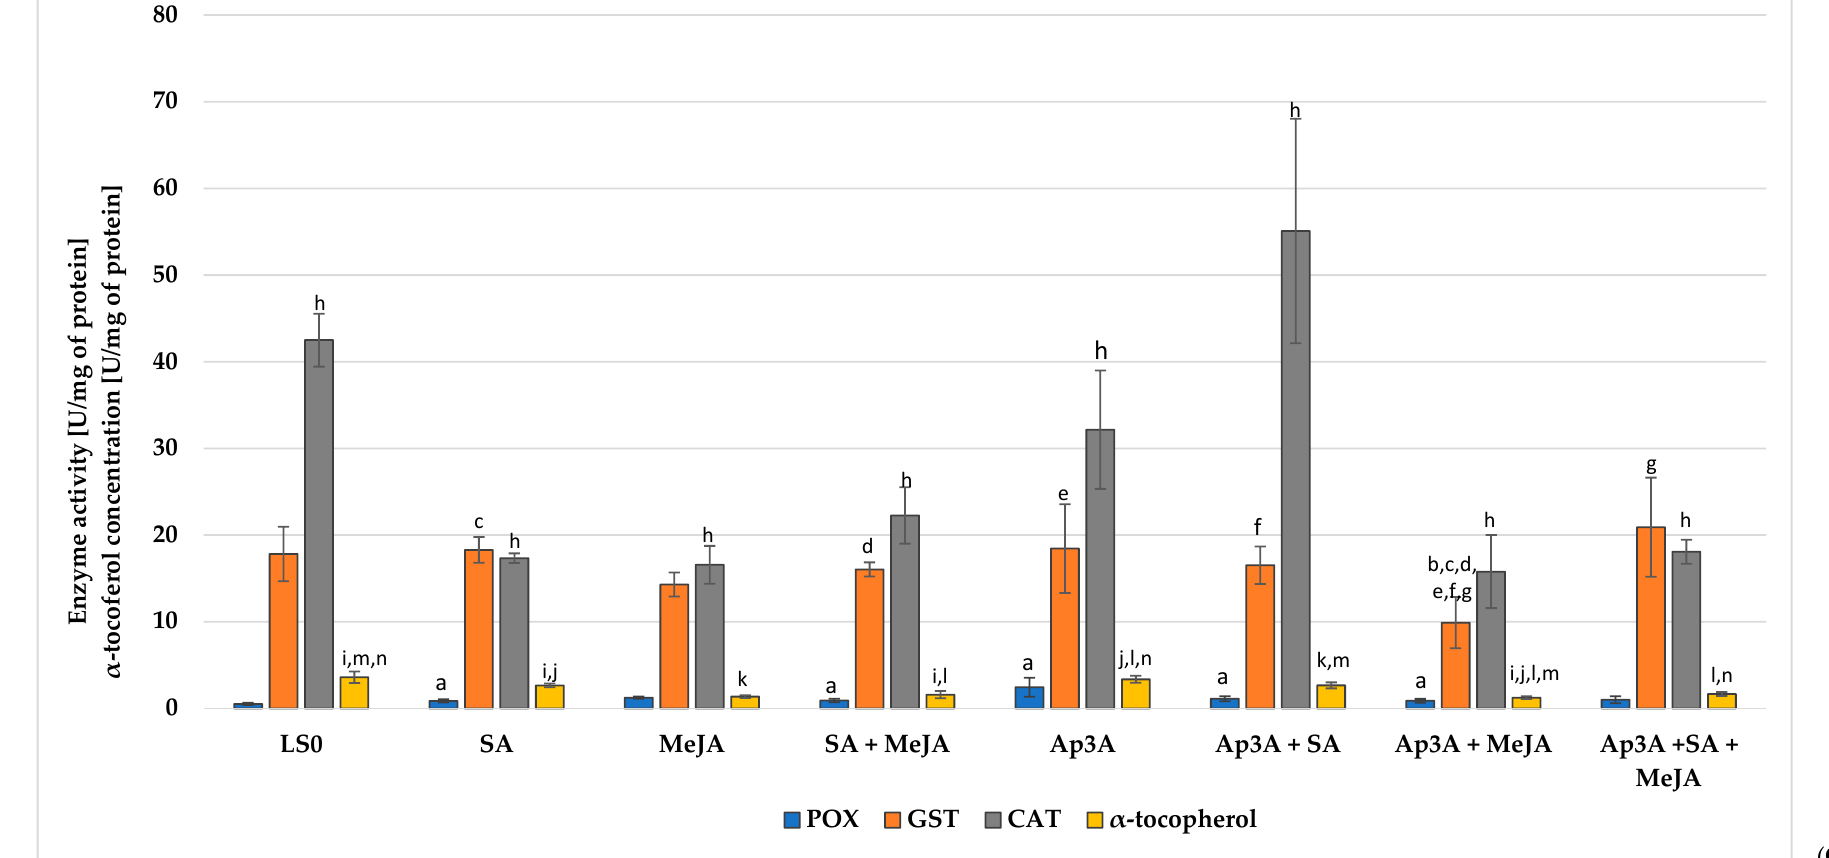
Figure 2. The influence of different modifications of LS medium supplemented with 8.88 µM BAP and 2.32 µM KIN on Polyscias filicifolia shoots: ( a ) protein level in extracts; ( b ) levels of lipid peroxidation; ( c ) activity of antioxidant enzymes and levels of non-enzymatic antioxidant α -tocopherol. Means denoted with the same letter were statistically significant ( p < 0.05).